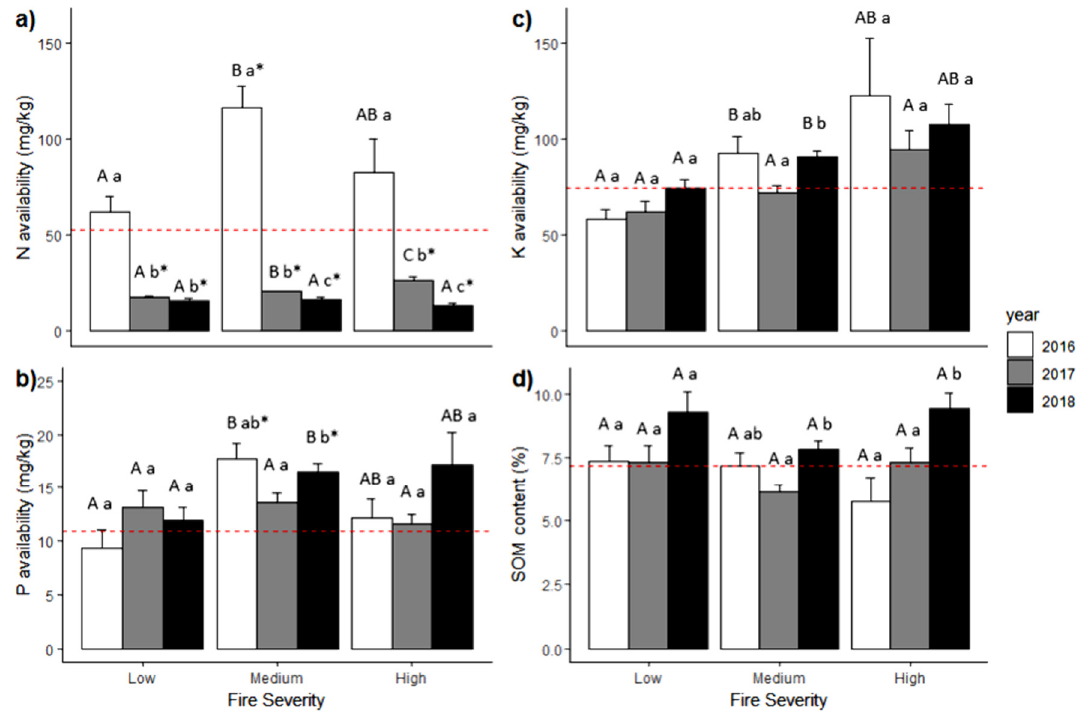
Figure 3. Mean values (+SE) of nutrient availability within a fire gradient (low, moderate, and high severity) over the years for ( a ) N, ( b ) P, ( c ) K, and ( d ) soil organic matter. The dashed red line is the reference mean value from the unburned forest. The uppercase letters represent significance difference between the fire severity levels in the same year ( α = 0.05), and the lowercase letters represent significance difference within the same fire severity level across the years ( α = 0.05) using Mann– Whitney U test. The asterisk (*) represents a significant difference compared to the unburned forest.